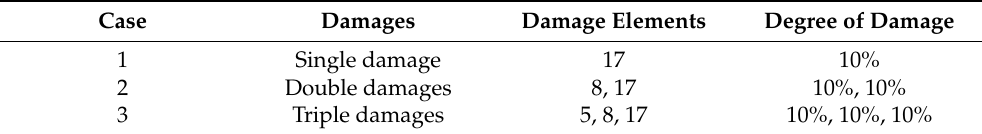
Table 4. Different damage cases of two-story rigid